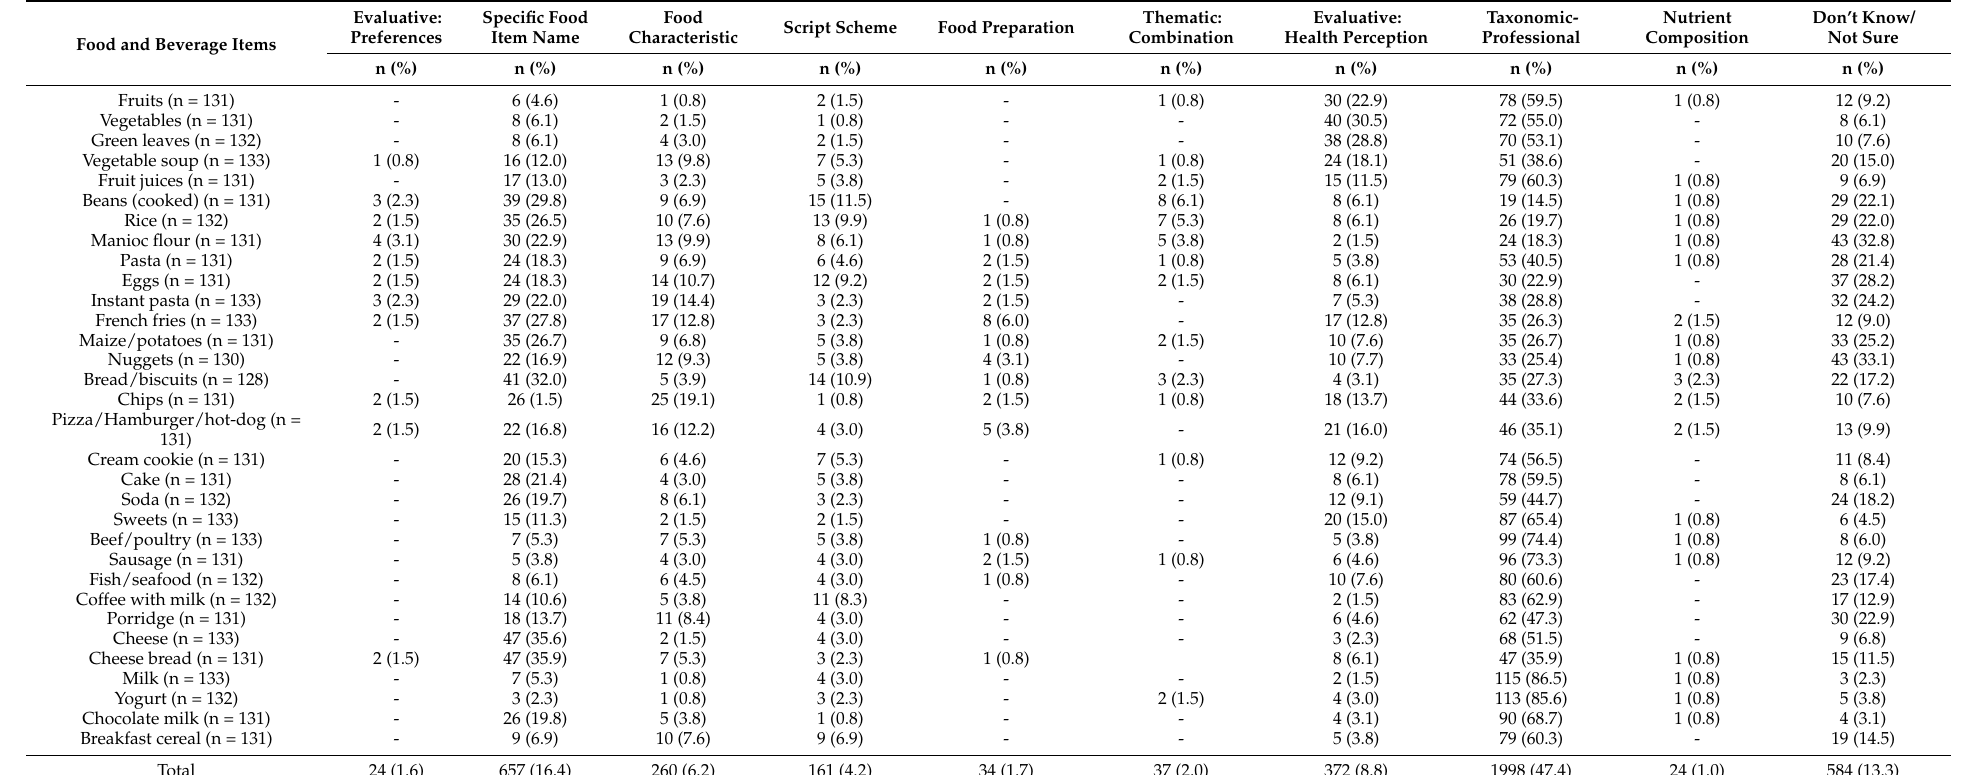
Table 4. Frequencies of 32 food and beverage items from Web-CAAFE according to conceptual